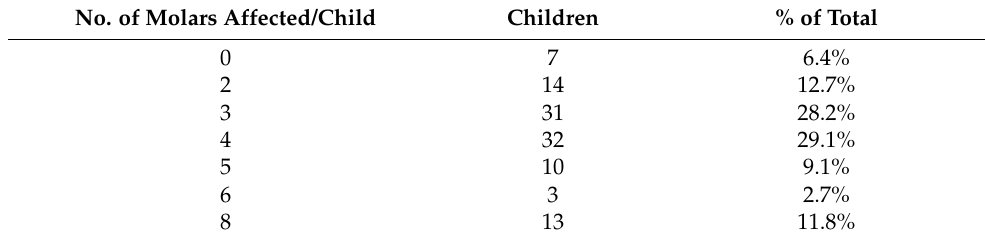
Table 4. Frequencies of the number of temporary molars affected for every